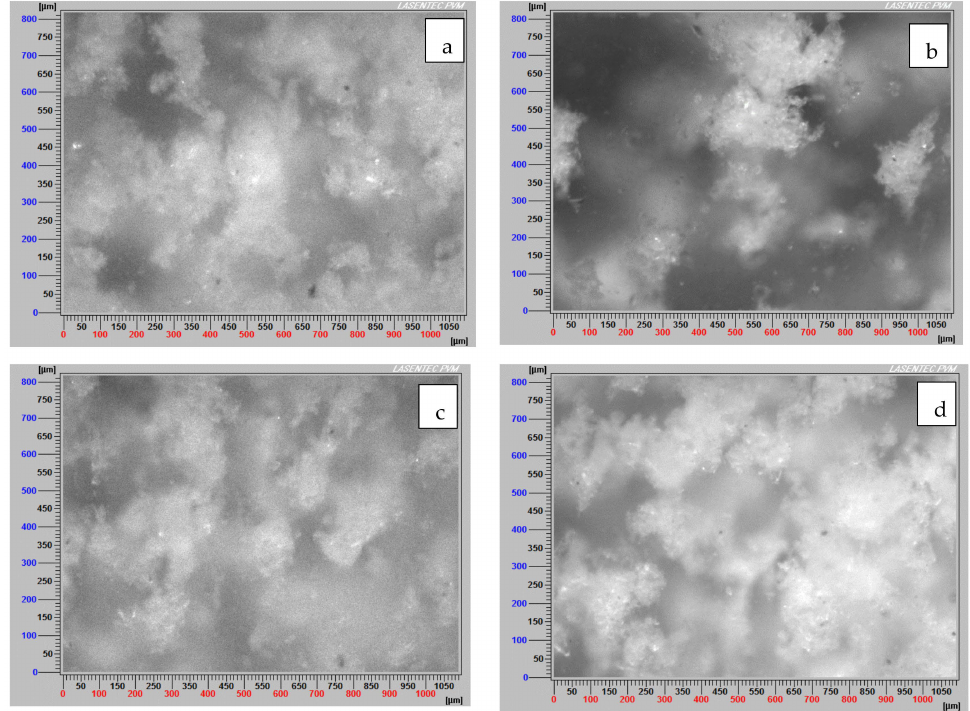
Figure 11. Images of flocculated tailings ( a ) KQ-SW, ( b ) KQ-IW, ( c ) MQ-SW, ( d ) MQ-IW. Flocculant dose 34 g/t, mixing rate 180 rpm, solids concentration 8 wt% (clay/quartz 10/90), flocculation time 20 s approx., pH